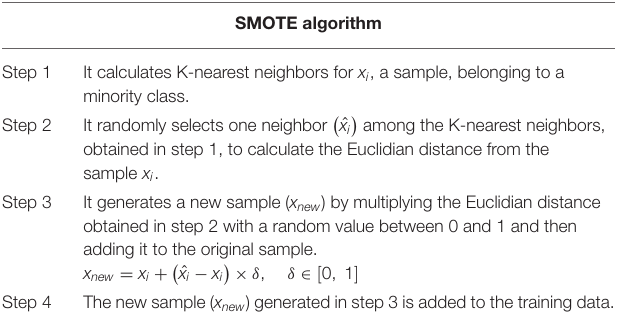
TABLE 1 | The procedure for performing SMOTE. SMOTE